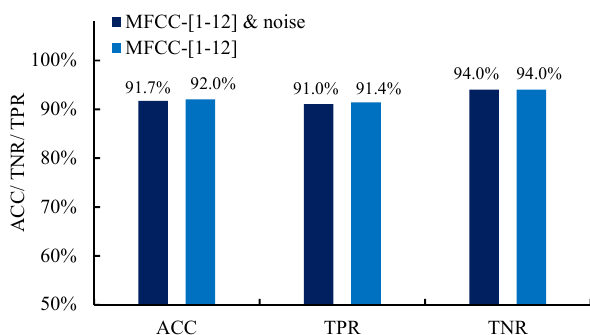
Figure 13. ACC, TNR, and TPR of AIEFPC on the sample set when using MFCC and noise features as sample features.